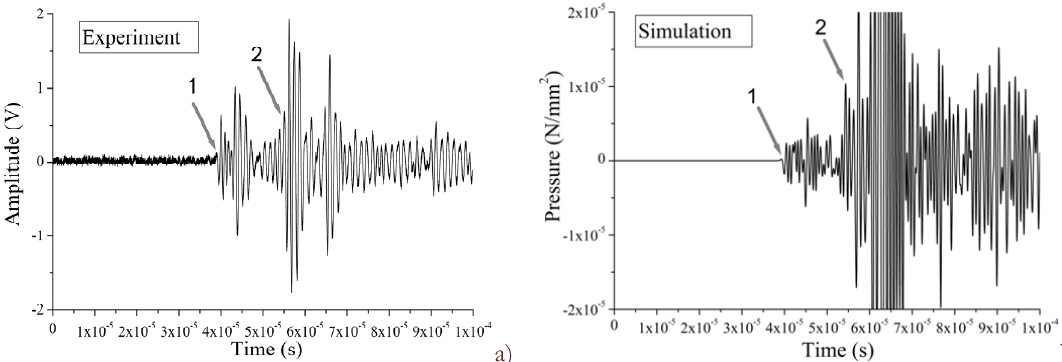
Figura 17: a) Tensione elettrica, proporzionale alla pressione dell’aria, in funzione del tempo per il trasduttore posizionato sul lato del fungo; b) pressione dell’aria misurata con l’approccio numerico nello stesso